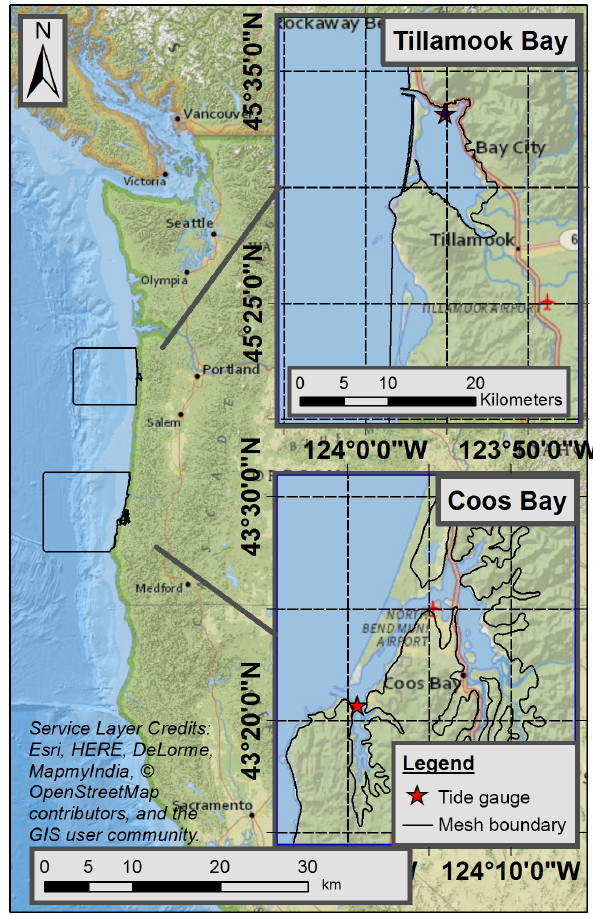
Figure 1. Overview map (left) and detailed views (inset boxes) of Tillamook and Coos bays on the US Pacific Northwest coastline. Both insets are at the same scale (shown on Tillamook Bay inset). The tide gauge locations are shown as red stars and the mesh bound- ary is shown as a dark line in both the overview and detailed view